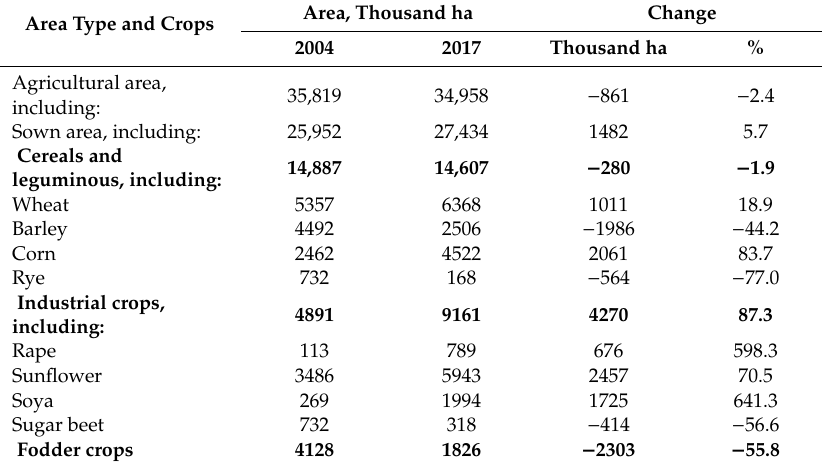
Table 2. Changes in agricultural land use in Ukraine from 2004 to 2017.